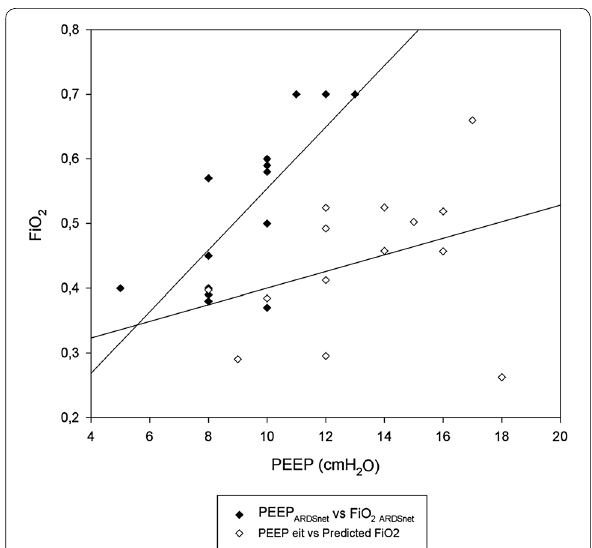
Fig. 3 Correlation between PEEP and FiO 2 set according to ARDSnet and EIT: As expected, there was a strong correlation between PEEP ARDSnet and FiO 2 set according to ARDSnet table ( R 2 p < 0.001); on the contrary, no significant association was observed